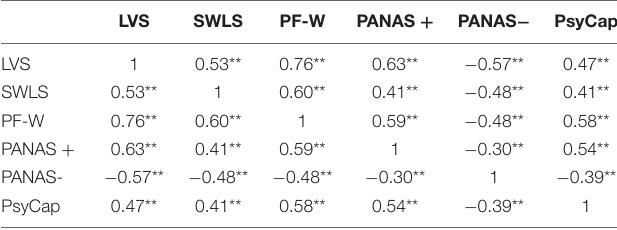
TABLE 9 | LVS correlations with Life Satisfaction, PF-W, PANAS, PsyCap.